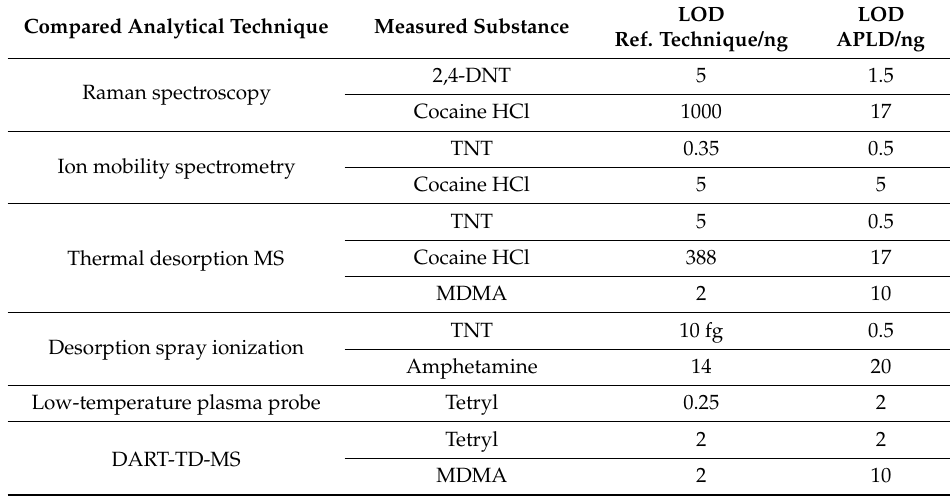
Table 3. Comparison of LOD of different analytical techniques to APLD for explosives and